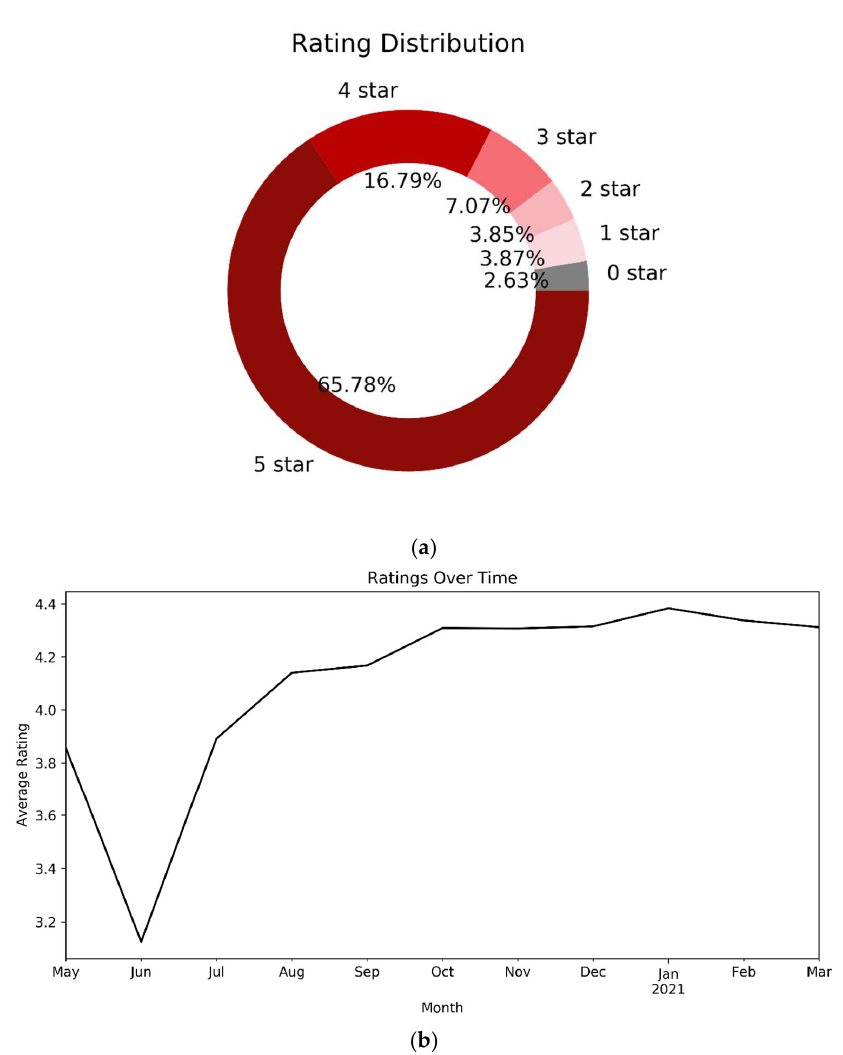
Figure 8. ( a ) Rating distribution of patients who rated the service via the mobile application. ( b ) Mean rating given by patients for all consecutive months from May 2020 to March 2021. Satisfaction data reveal that, of the 7749 patients who responded, 76.47% were happy about the service they received from the ED. A 15.58% proportion responded that they